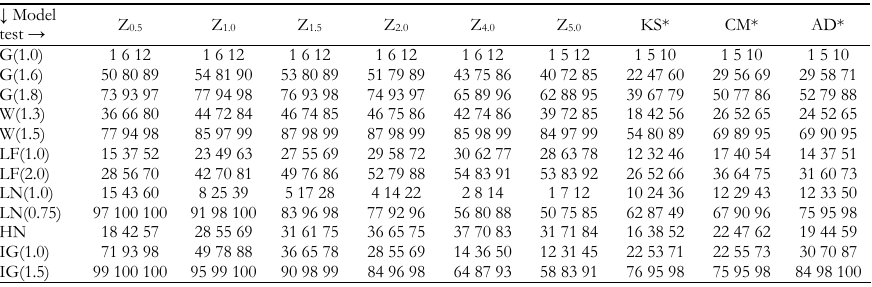
with sample size n =